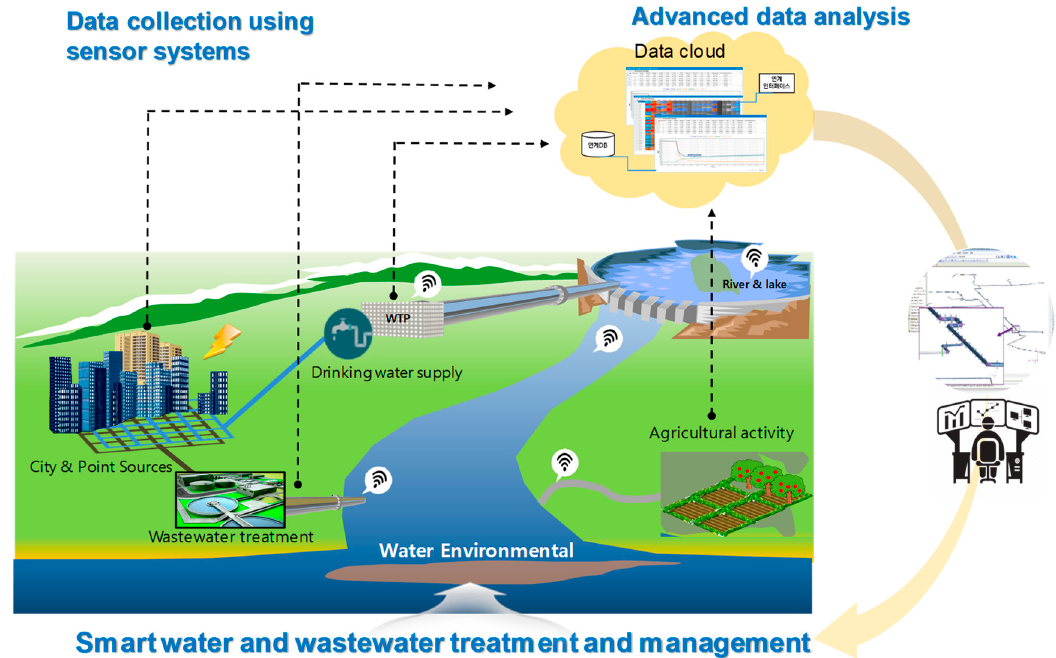
Figure 1. Schematic of the combination of real-time monitoring, transmission, and advanced data management system for smart water and wastewater treatment and management.